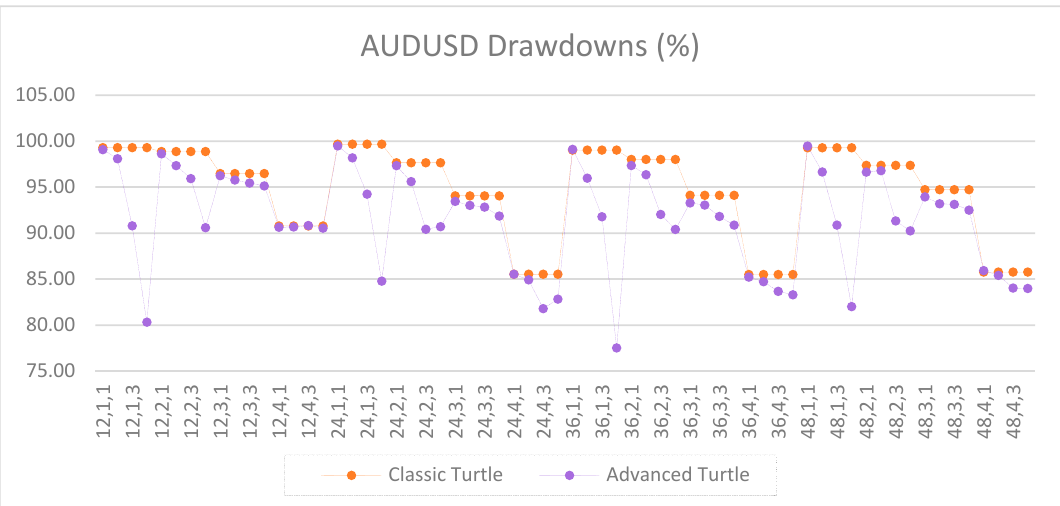
Figure A1. Net profits of AUDUSD between the classic and the advanced Turtle systems for every combination of N, X, Y for the fast parameters (20, 40).